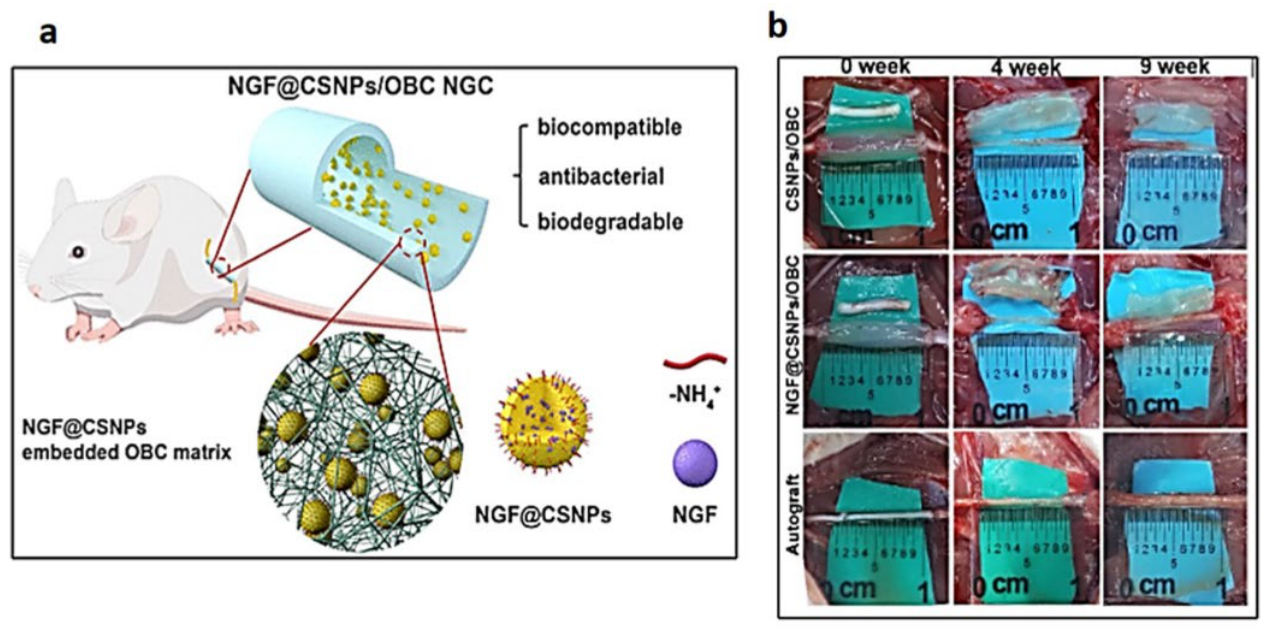
Figure 7. ( a ) Schematic representation of the process of incorporating growth factors into BC-based NGC and its implantation into a rat. ( b ) The digital photographs of the peripheral nerve regeneration, the BC conduits and transplantation at week 0, rat’s sciatic nerve regeneration at weeks 4 and 9 weeks post-surgery. Adapted from Wei et al. [156].